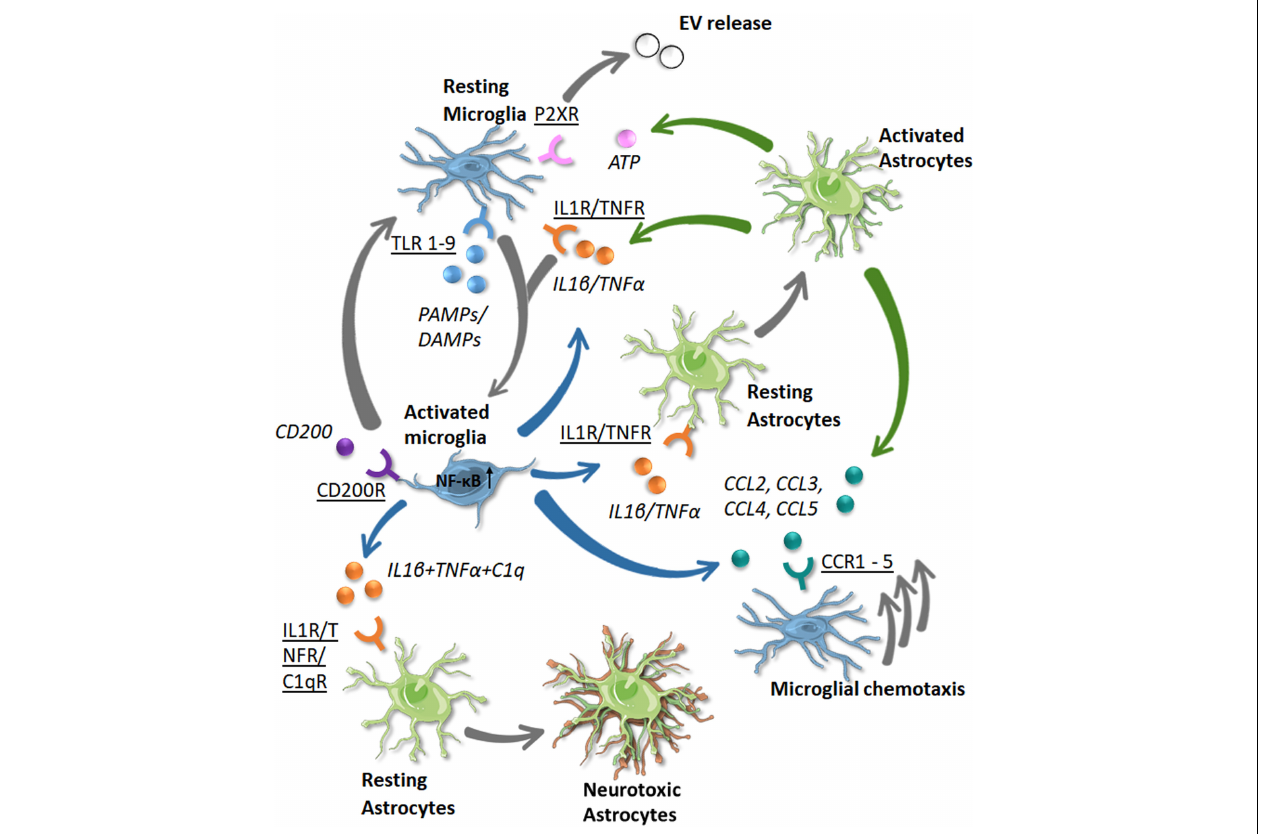
FIGURE 5 | Known communication pathway between microglia and astrocytes in the human brain in response to disease. Receptors (underlined) and the signaling molecules (italic) are shown with the color of the arrow denoting the cell source (green = astrocytes, blue = microglia). The resulting phenotypic changes or movements are shown by gray arrows (single or triple, respectively). As microglia become activated by PAMP/DAMP signaling via TLR receptors (both blue), they become activated (gray arrow). Activated microglia release IL1 β and TNF α which bind through IL1R and TNFR receptors to activate astrocytes and other microglial cells. This signaling with the addition of C1q signaling on astrocytes leads to a neurotoxic phenotype, with a loss of neuroprotective functions. Activated astrocytes release IL1 β and TNF α to propagate a neuroinflammatory response. They also release ATP which binds to P2XR receptors on microglia, leading to extracellular vesicle release. Activated astrocytes and microglia may also release chemokines (CCL2–CCL5) which bind to receptors on microglia (CCR1–CCR5) and stimulate their chemotaxis toward the site of injury/pathogen. Inflammation is in part resolved by CD200 binding to CD200R on activated microglia, leading them to return to a homeostatic